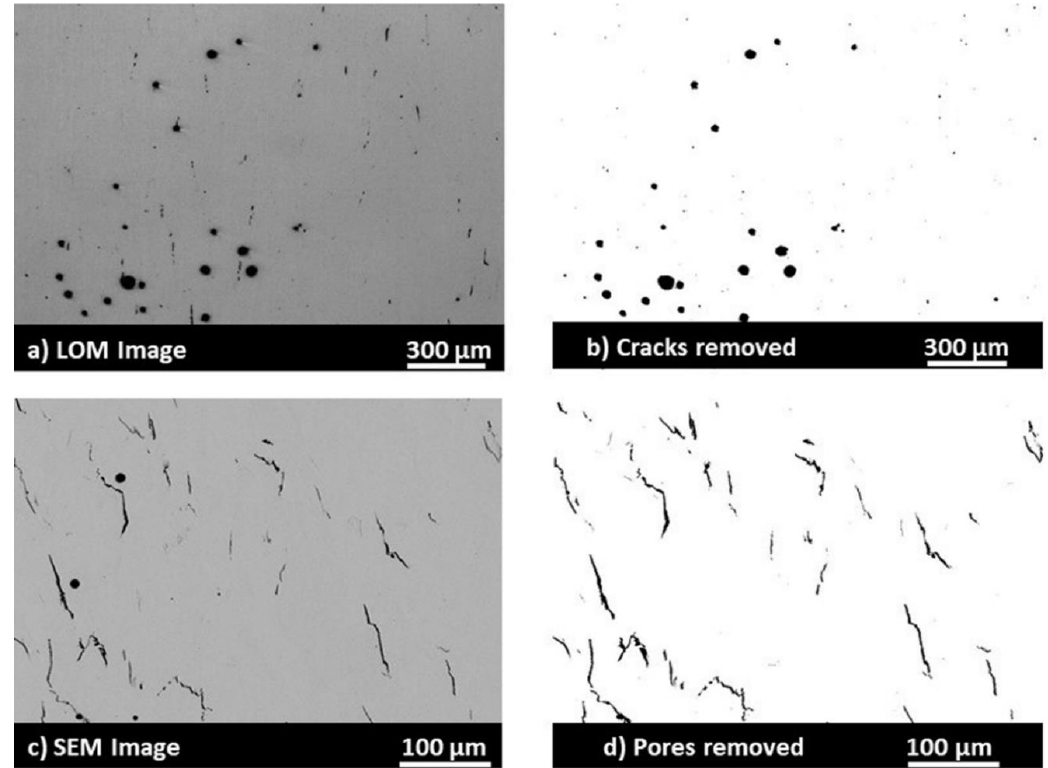
Figure 4. ( a ) Light optical microscope (LOM) image showing the pores and cracks; ( b ) Post-processed LOM image revealing only pores for the residual porosity determination; ( c ) SEM image showing pores and cracks; ( d ) Post-processed SEM image exhibiting only cracks for the cracking density determination.